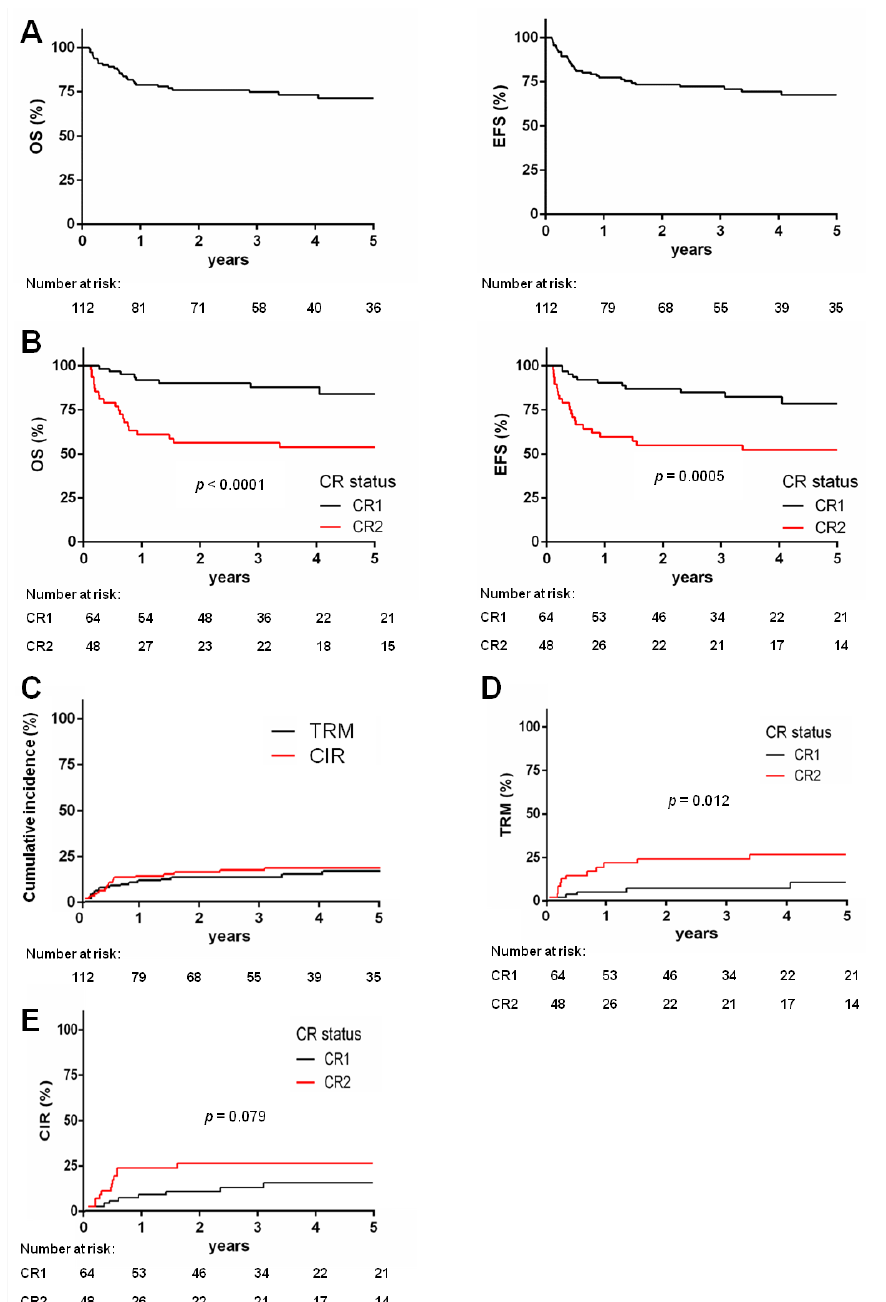
Figure 1. Survival of the whole patients’ cohort according to the remission status before HSCT: ( A ) Kaplan–Meier estimates showing 5-year probability of overall survival (OS, left, survival 71.4%) and event-free survival (EFS, right, survival 67.6%) for the whole cohort of patients enrolled ( n = 112); ( B ) five-year probability of OS (left) for children receiving HSCT in CR1 ( n = 64) or CR2 ( n = 48) (84% vs. 53.9%, p < 0.0001) and EFS for patients transplanted in CR1 or CR2 (78.6% vs. 52.3%, p = 0.0005); ( C ) cumulative incidence of treatment-related mortality (TRM) in the whole population of children given HSCT (black line, n = 112, 13.5%), and cumulative incidence of relapse (CIR) in the whole population of AML patients given transplantation (red line, n = 112, 17.1%); ( D ) cumulative incidence of transplant-related mortality in patients who underwent transplantation in CR1 ( n = 64) or CR2 ( n = 48) (8.8% vs. 24.4%, p = 0.012); ( E ) cumulative incidence of relapse in patients who underwent transplantation in CR1 ( n = 64) or CR2 ( n = 48) (12.7% vs. 23.3%, p = 0.079).